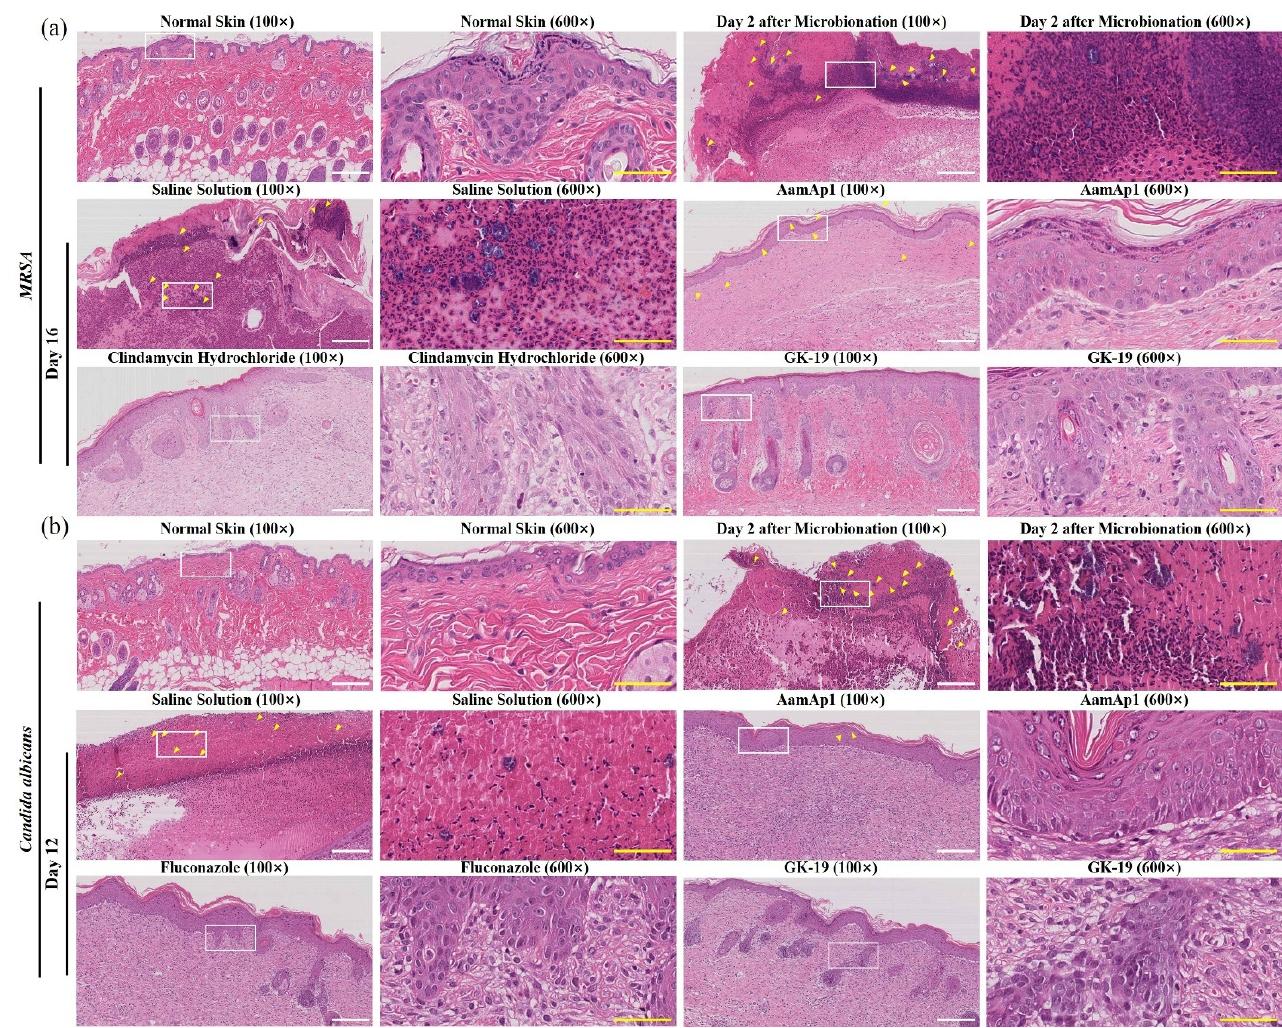
Figure 5. The histology analysis of skin samples of the scalded mice infected by MRSA ( a ) or C. albicans ( b ). The skin wounds were treated with saline solution, AamAP1, GK-19, clindamycin hydrochloride (for MRSA infection), or fluconazole (for C. albicans infection), respectively, and the concentration of drugs was 50 µ M. Skin samples were harvested at different time points. White scale bar: 200 µ m. Yellow scale bar: 50 µ m. Yellow arrows indicate the location of bacterial or fungal